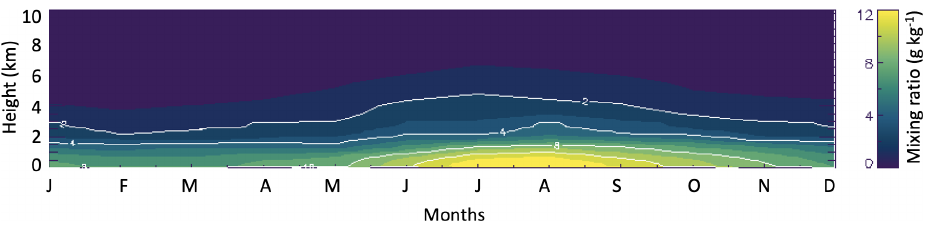
Figure 1. Monthly averaged water vapor mixing ratio (shades) and contours (white lines) from radiosondes at the ARM ENA site during marine